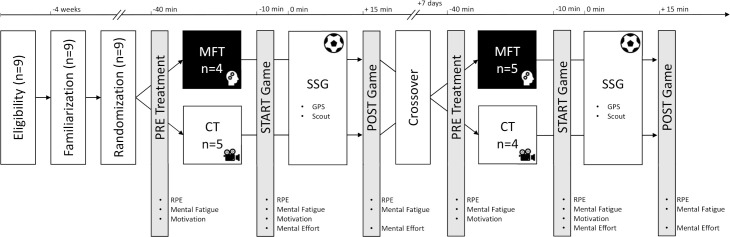
A schematic layout of the experimental design.MFT = mental fatigue group, CT = control group, RPE = rate of perceived exertion, SSG = small-sided games, GPS = global positioning system.